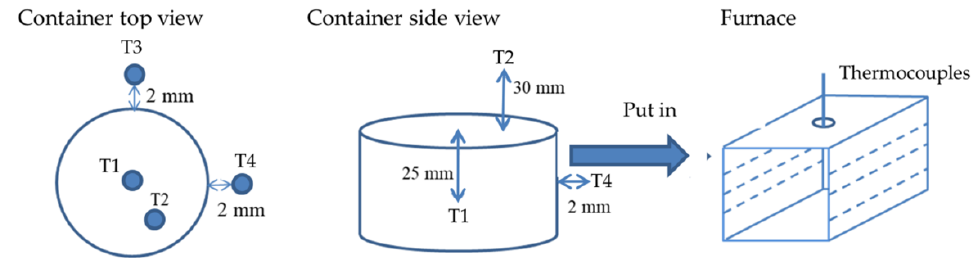
Figure 1. Experimental apparatus and temperature measurement points.